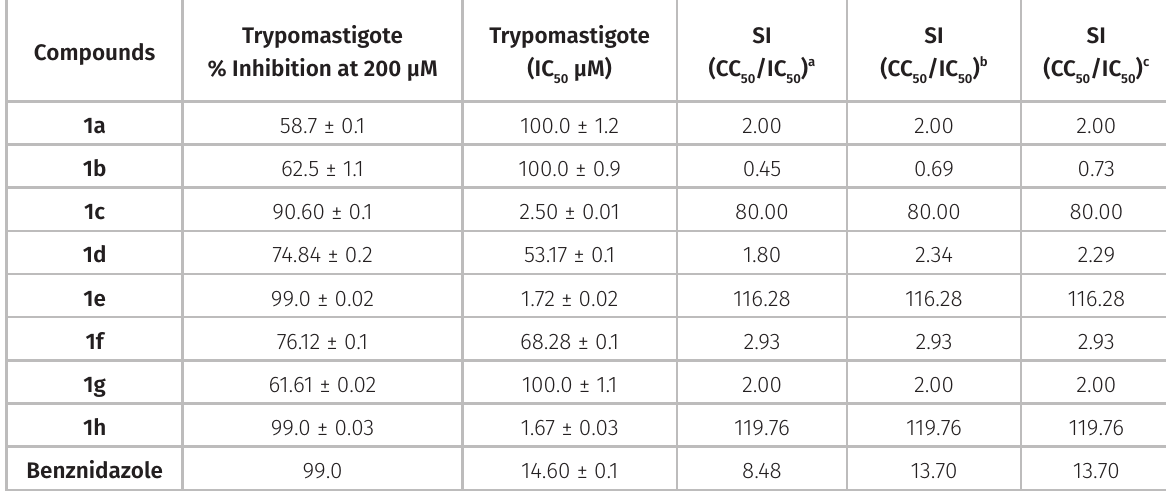
Table V. Antitrypomastigote activity results obtained by the compounds expressed as percentage of inhibition at a concentration of 200 µM in addition to IC